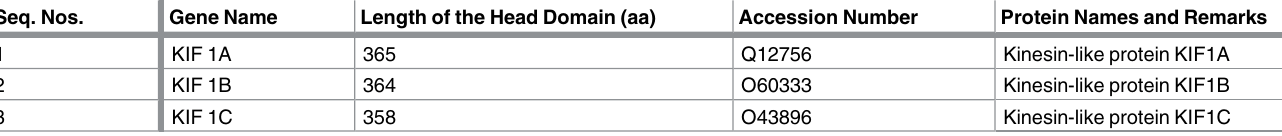
Table 5. Details of kinesin sub-family KIF 1A class membersin human. Seq. Nos.